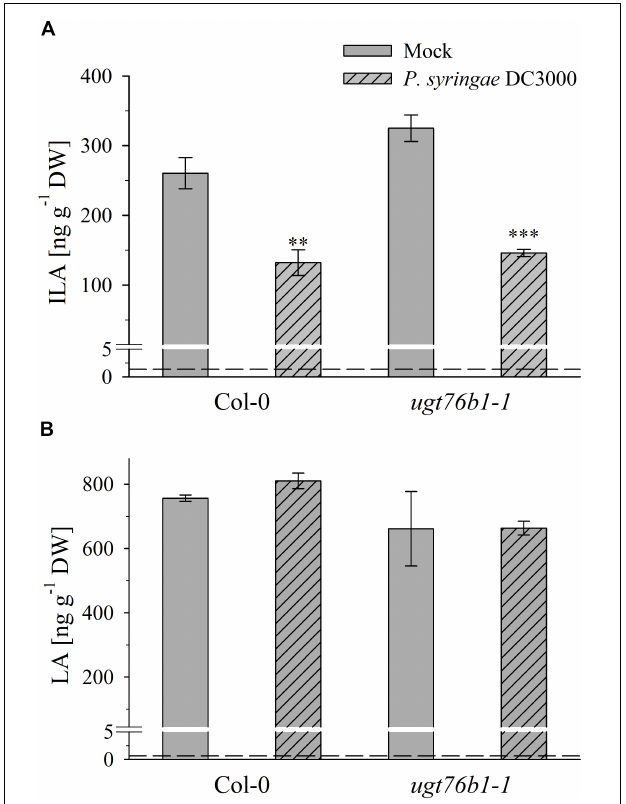
FIGURE 7 | Isoleucic acid and LA abundance in response to Pseudomonas syringae virulent strain infection. Levels of (A) ILA and (B) LA aglyca 24 h post P. syringae DC3000 infection in leaves of Arabidopsis Col-0 and ugt76b1-1 plants compared to mock controls. Means ± SE ( n = 4) are plotted. Asterisks indicate statistically significant treatment effect compared to mock control ( t -test), ∗∗ p < 0.01, ∗∗∗ p < 0.001. Dashed lines indicate the limit of detection (see section “Materials and